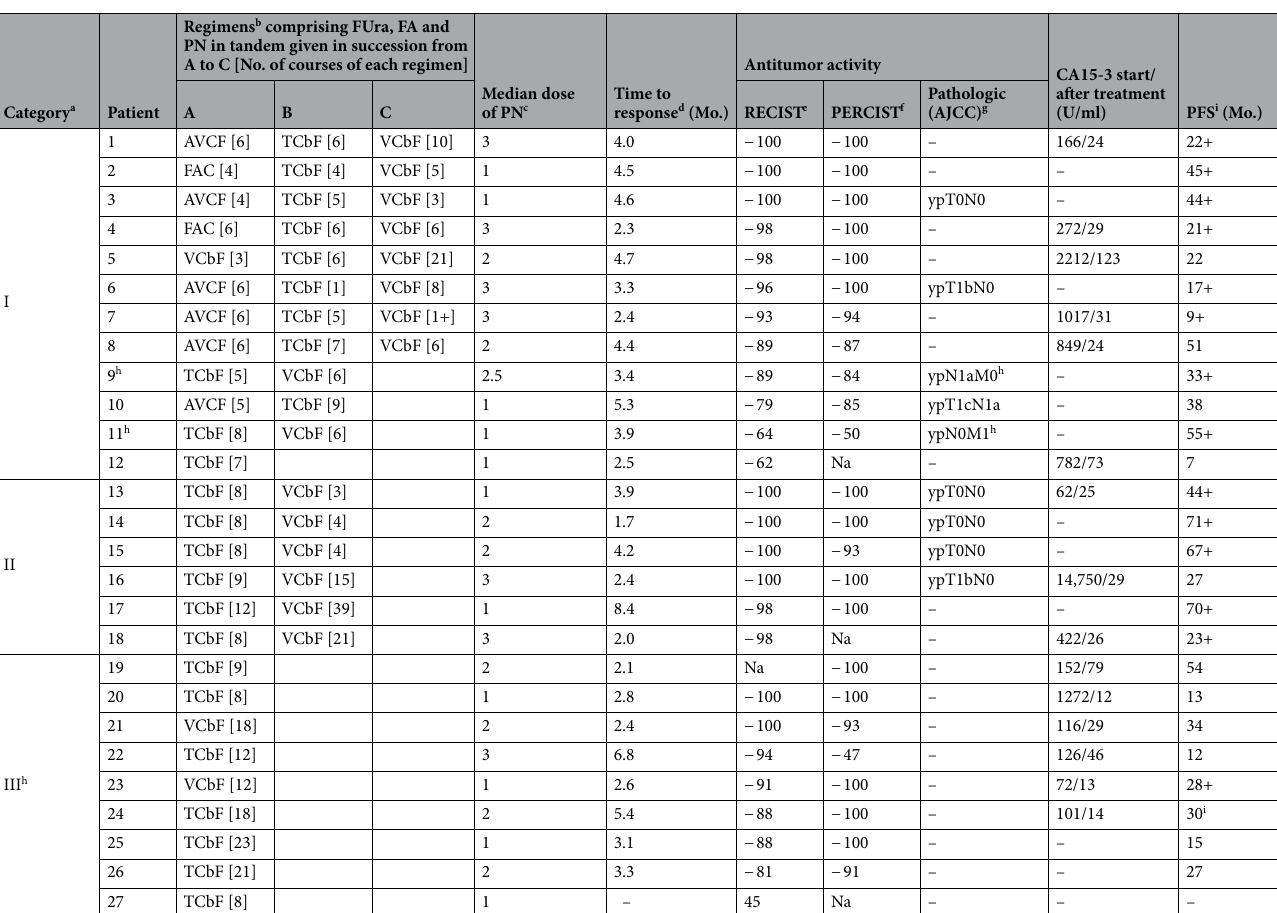
Table 2. Results of therapy in patients with advanced breast carcinoma treated with regimens comprising 5-fluorouracil, folinic acid, and pyridoxine in tandem. a Categories comprise I, previously untreated patients whose tumors did not overexpress HER2 (1–12); II, previously untreated patients whose tumors overexpressed (3+) HER2 (13–18); and III, previously treated patients whose tumors did not overexpress HER2 (19–27). b Composition of regimens is described in text. c Median dose of PN preceding each injection of FUra and FA (× 10 3 mg/day). d Time to attain antitumor response, i.e., reduction in sum of diameters by ≥ 30%. e Patients who attained a PR accompanied by disappearance of most metastases had RECIST (Response Evaluation Criteria in Solid Tumors) values calculated by size comparison of persisting tumors at the time of assessment with these same tumors before treatment. f Percent variation in peak standard 18 FDG uptake value normalized by lean body mass (SUL peak ) assessed by PET scan (PERCIST; Positron Emission Tomography (PET) Response Evaluation Criteria in Solid Tumors). g Pathologic response was assessed by mastectomy or by locoregional resection with eradication intent in patients with prior mastectomy. h Patient with prior mastectomy. i EFS time in Patient 24. Na not